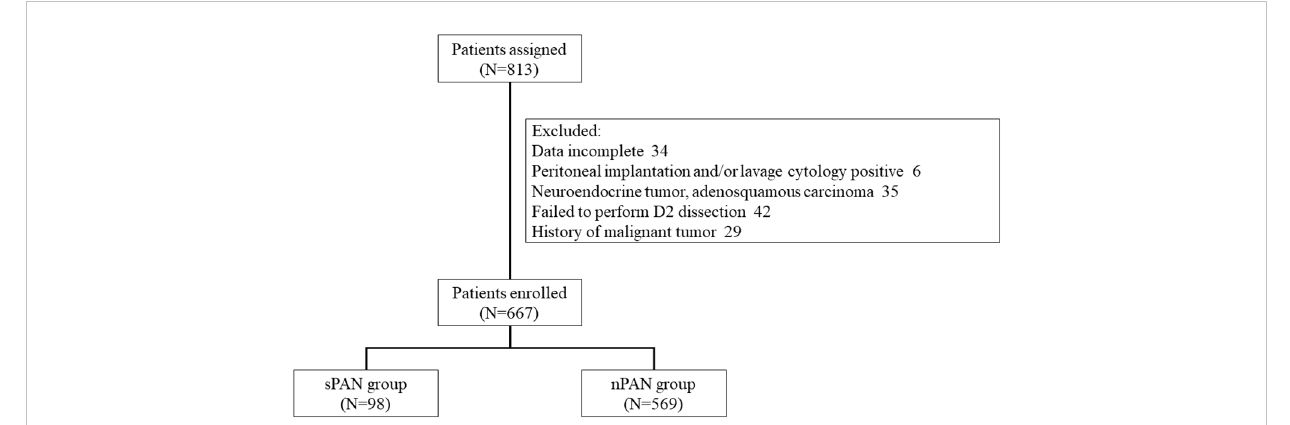
FIGURE 2 Flow diagram of treatment patterns. SPAN. small para-aortic lymph node; nPAN, non para-aortic lymph node.